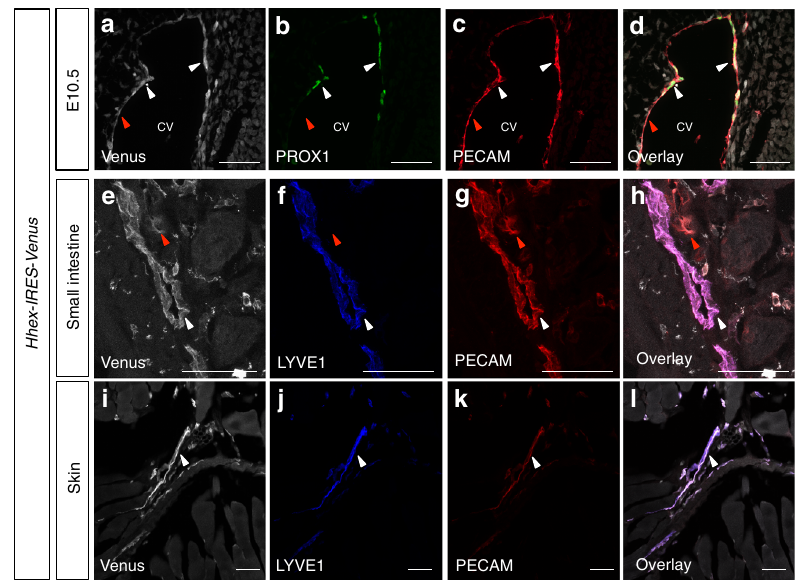
Fig. 5 Hhex-IRES-Venus is expressed by vascular endothelial cells and lymphatic endothelial cells during mouse development and adulthood. a – d Maximum intensity projections of confocal images of an E10.5 Hhex-IRES-Venus embryo in the CV region after Venus (white), PROX1 (green), and PECAM (red) immunostaining. e – l Maximum intensity projections of confocal images of an Hhex-IRES-Venus adult mouse small intestine ( e – h ) and skin ( i – l ) after Venus (white), LYVE1 (blue) and PECAM (red) immunostaining. Hhex-IRES-Venus expression is observed in blood endothelial cells (red arrowheads) as well as LECs (white arrowheads). Scale bars: 50 μ